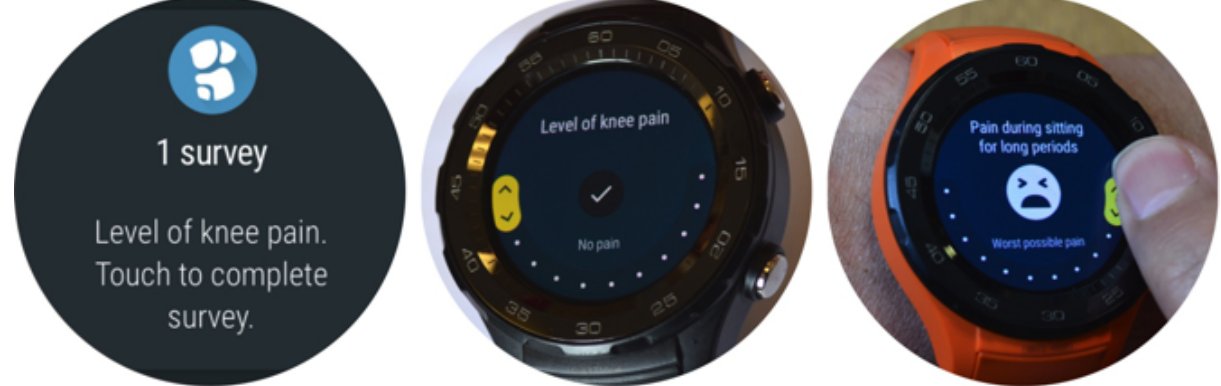
Figure 1. User interface of KOALAP app. Left: notification of an active survey; middle: data entry screen for survey “level of knee pain”; right: data are entered by swiping the numeric rating scale